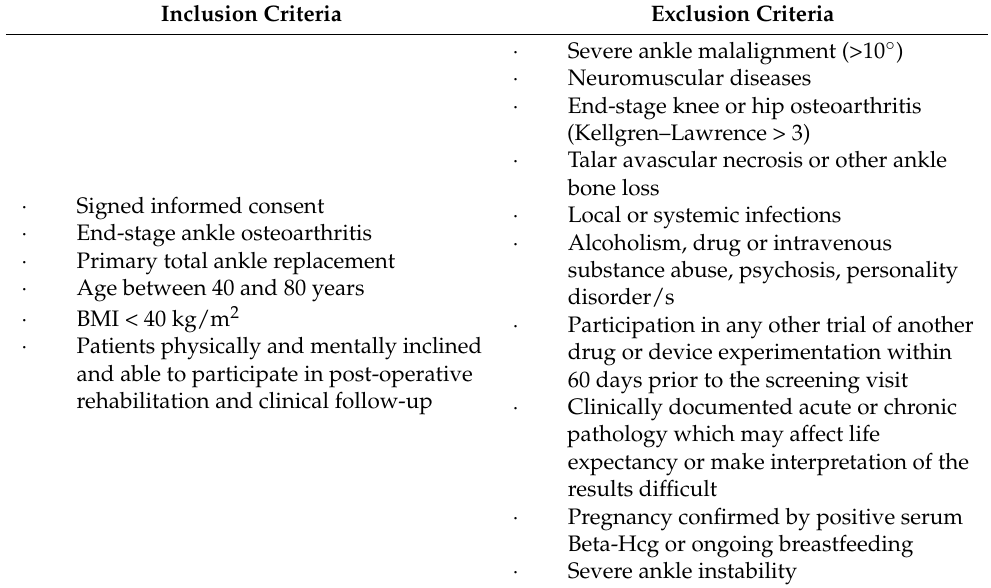
Table 1. Inclusion and exclusion criteria. Inclusion